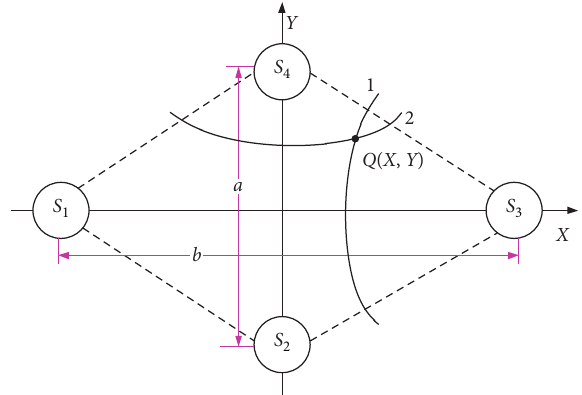
Figure 1: The AE sound source positioning of an array composed of four AE